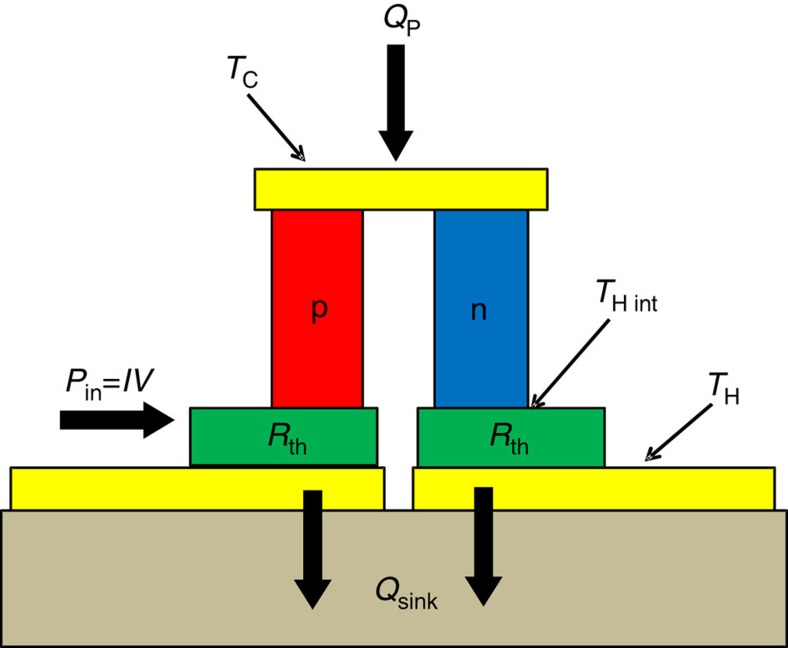
Thin-film thermoelectric module structure.The red and blue rectangles represent the p- and n-type active TE materials, respectively. Yellow represents the current traces and tan represents the ceramic bottom header of the module. Heat entering the module is given by QP, while the heat being pumped out is given by Qsink. TC, TH and TH int are the cold-side temperature, externally measured hot-side temperature and internal element hot-side temperature, respectively. The green rectangles represent the parasitic thermal resistances Rth, which reduce the externally observed ΔT value. Figure is not drawn to scale.